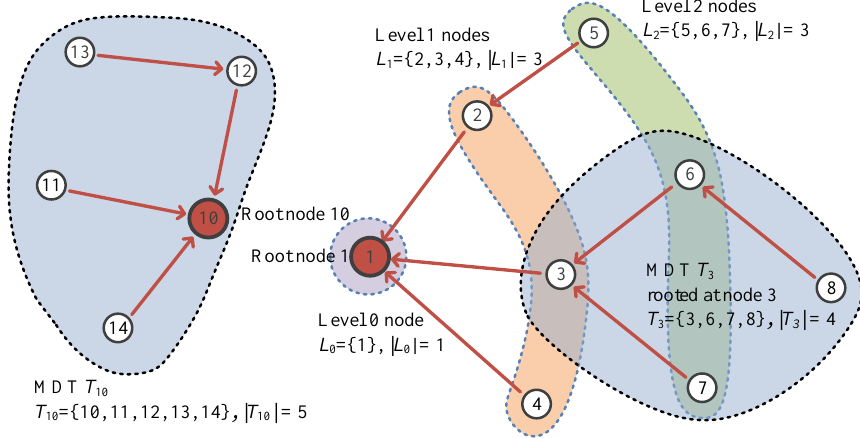
Figure 2. Example of MDT with presentation of key